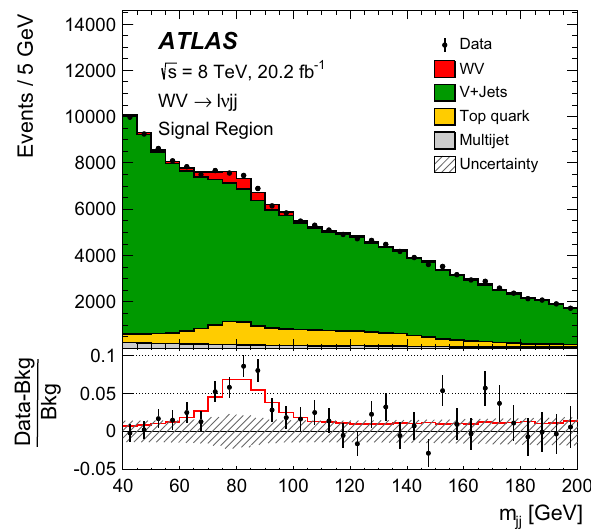
Fig. 4 The observed m jj distribution in the WV → (cid:4)ν jj signal region, overlaid with the post-fit background and signal estimates. The hatched band indicates the total uncertainty of the fit